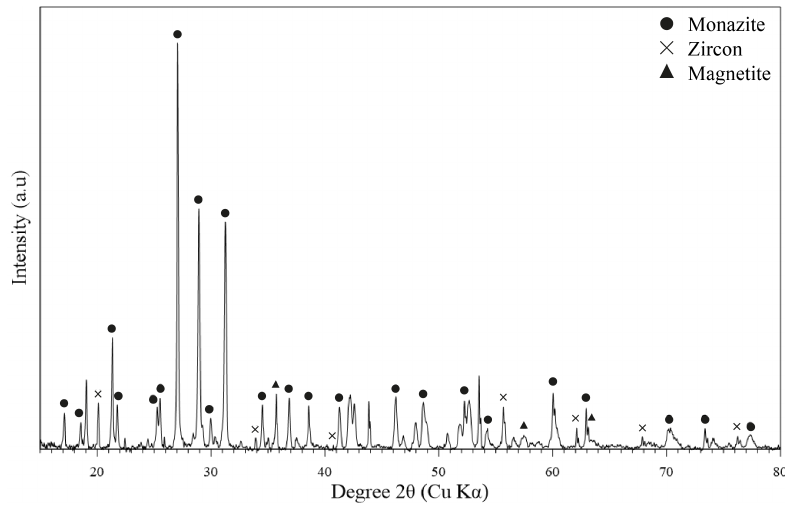
Figure 9. XRD diffractogram of the monazite